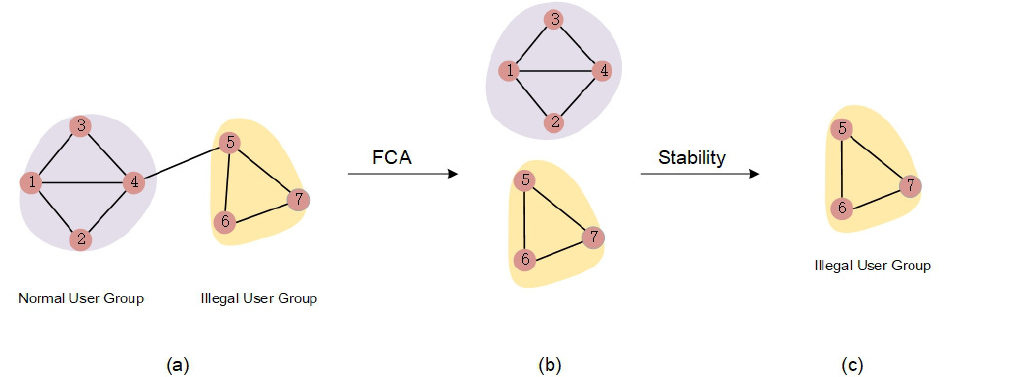
Figure 1. An illustration of the role of FCA and stability in identifying illegal users in social networks. ( a ) a social network including a normal user group and an illegal user group. ( b ) the network structure identified by FCA without distinction. ( c ) an illegal user group accurately identified by stability